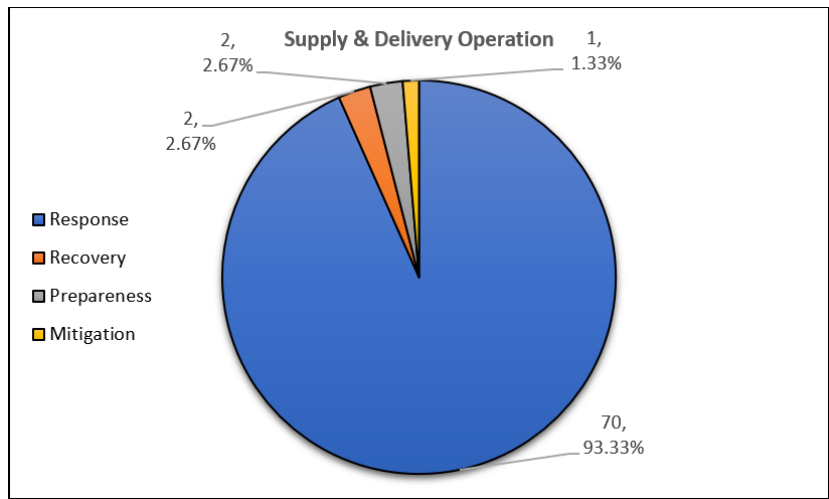
Figure 7. Breakdown of VRP for Supply & Delivery Operation based on DM